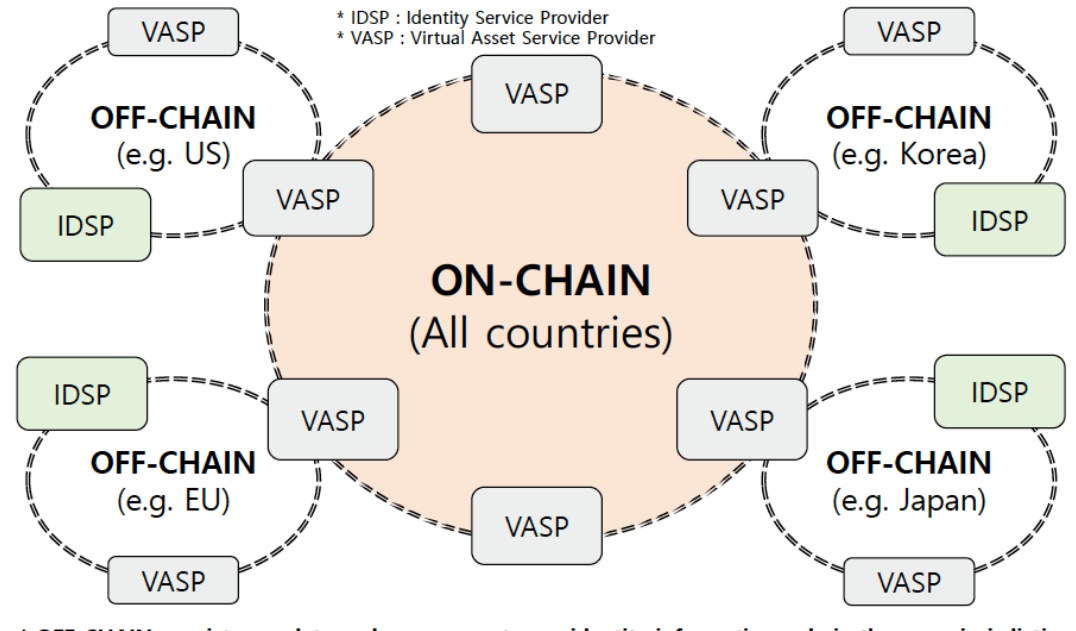
Figure 5. A diagram of the DLT security platform consisting of OFF-CHAIN and ON-CHAIN.